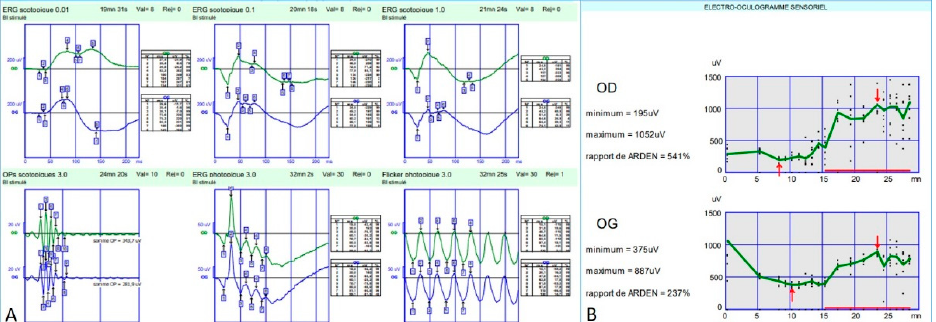
Figure 7. Electrophysiology findings in both eyes. ( A ) f-ERG: Rod response amplitude and peak time within normal limits in scotopic conditions. Normal oscillatory potentials (preserved macular function). Photopic responses amplitude and peak time within normal limits. Regular periodic flicker responses (preserved M- and L-cones function). ( B )- EOG: Arden ratio within normal limits. Electro-oculogram (EOG) (Metrovision, Perenchies, France) revealed an Arden ratio within normal limits in both eyes (Figure 7B).